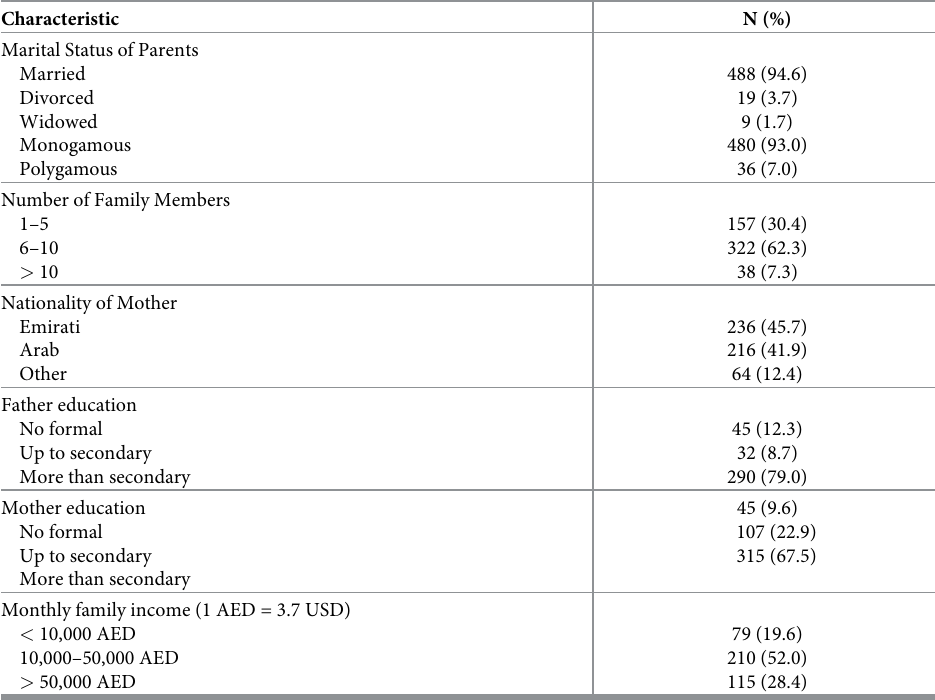
Table 2. Characteristics of adolescents’ parents in Al Ain, United Arab